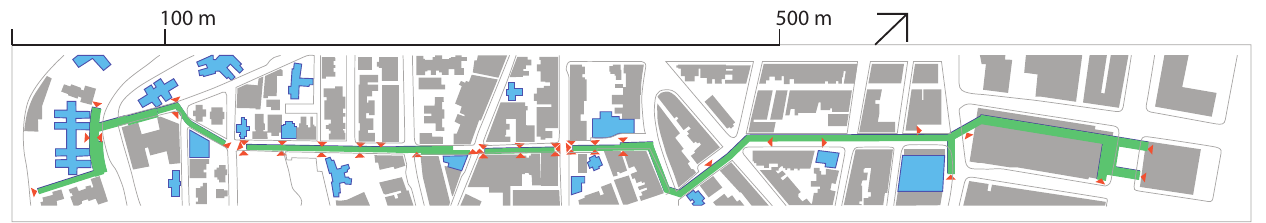
Figure 4. The Mid-levels escalator, travelator and walkway are shown in green with entry points in red. Buildings constructed since 1994, the year of construction of the system, are shown in